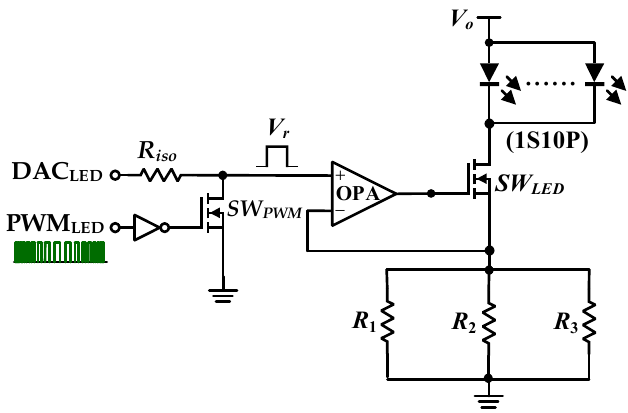
Figure 9. Scheme of the dimming with VDSV method.